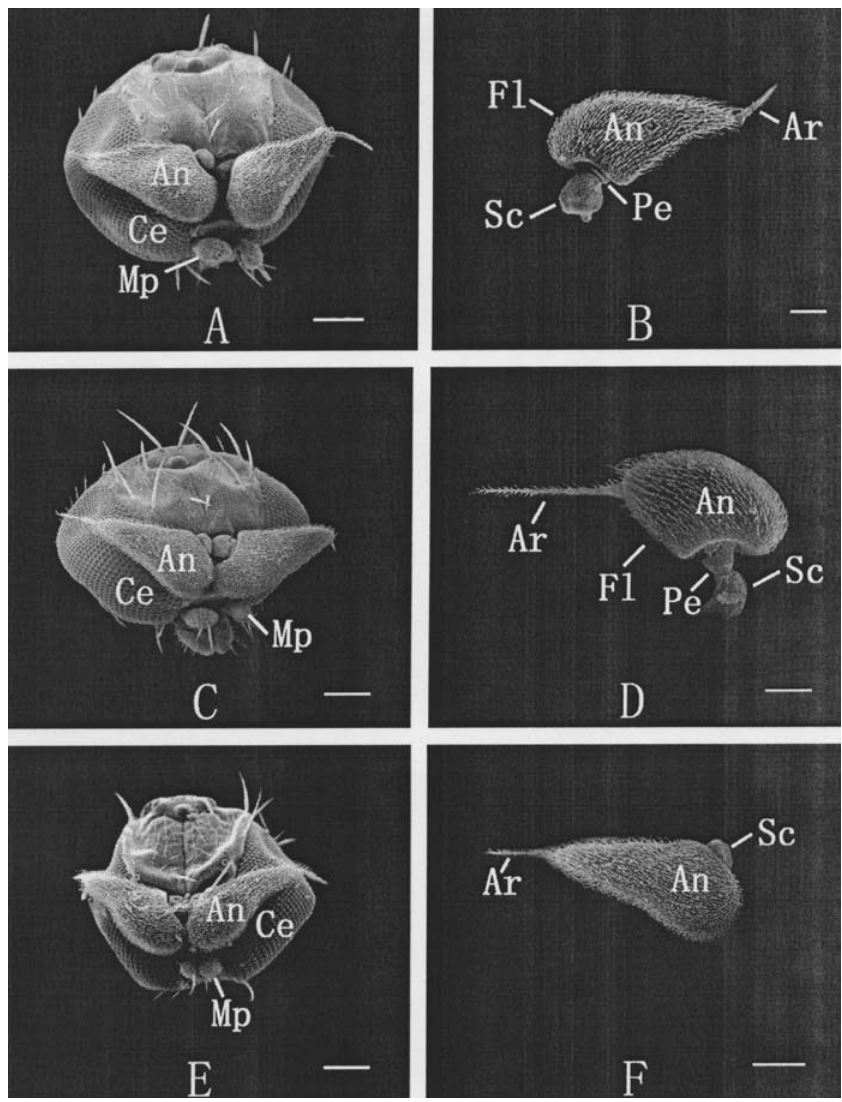
Fig.1 SEM micrographs of heads and antenna of the decapitating phorid flies females P. litoralis , P. obtusus and P . tricuspis (A) P. litoralis head; (B) P. litoralis antenna; (C) P. obtusus head; (D) P. obtusus antenna; (E) P. tricuspis head; (F) P. tricuspis antenna. An, Antenna; Ce, compound eyes; Mp, maxillary palp; Ar, Arista; Pe, Pedicel; Fl, Flagellum; Sc, Scape. Scale bars: (A, C, and E) 100 μm; (B, D, and F) 50